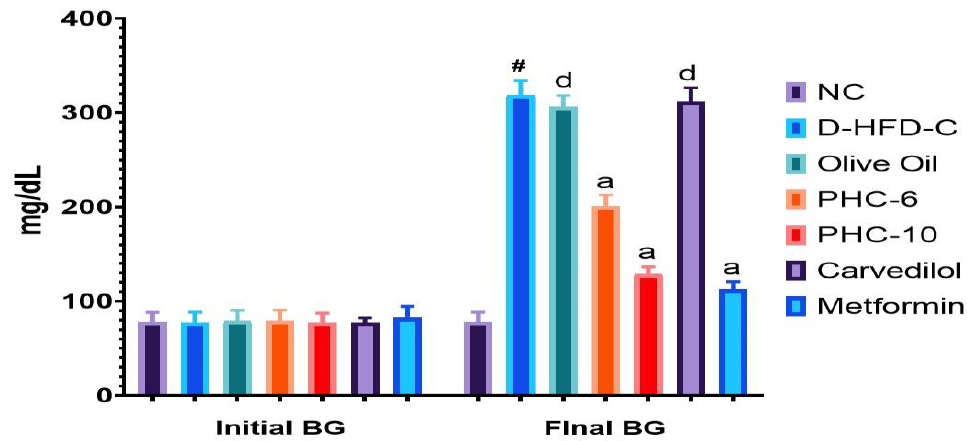
Figure 1. Initial and final blood glucose levels. All values are expressed as mean ± SD ( n = 6) ana-